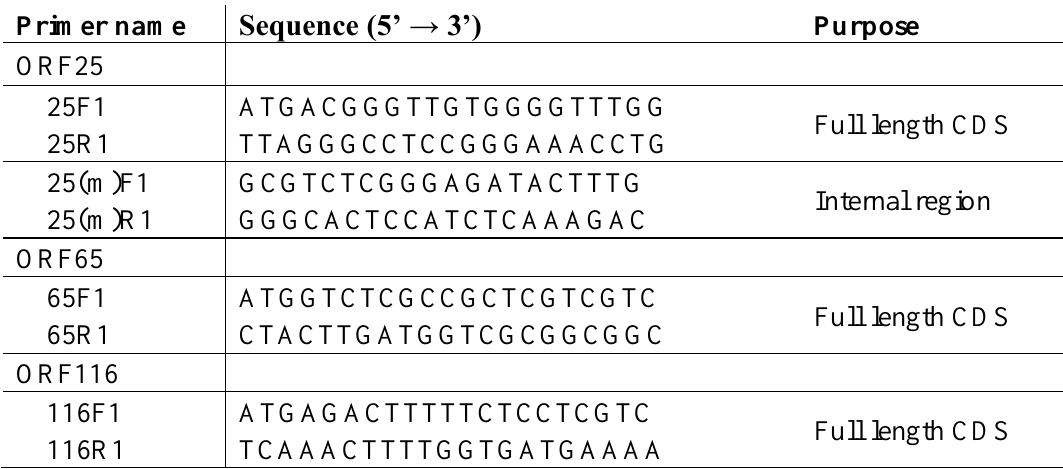
Table 1. Primers used in this